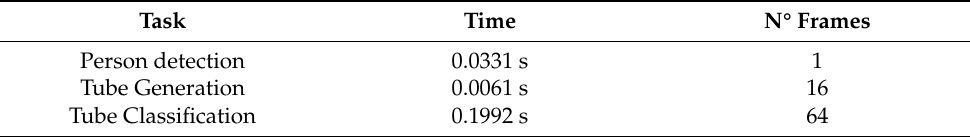
Table 10. Inference time for each stage on the proposed